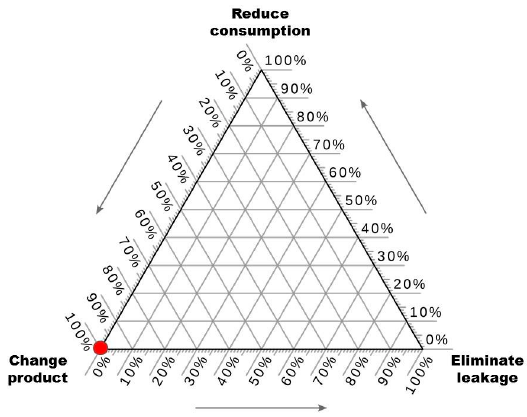
Figure 2. Driving solely a product replacement approach.